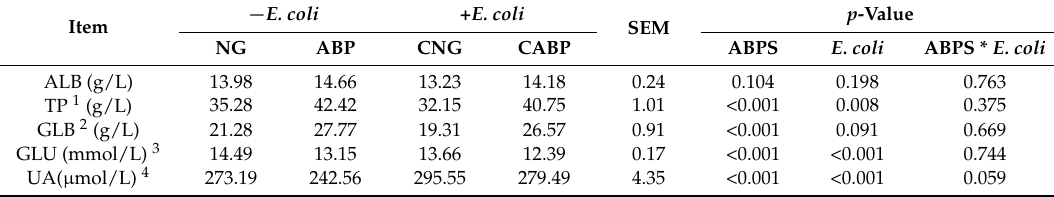
Table 3. Effects of ABPS and E. coli challenge on serum biochemical indices of yellow-feathered